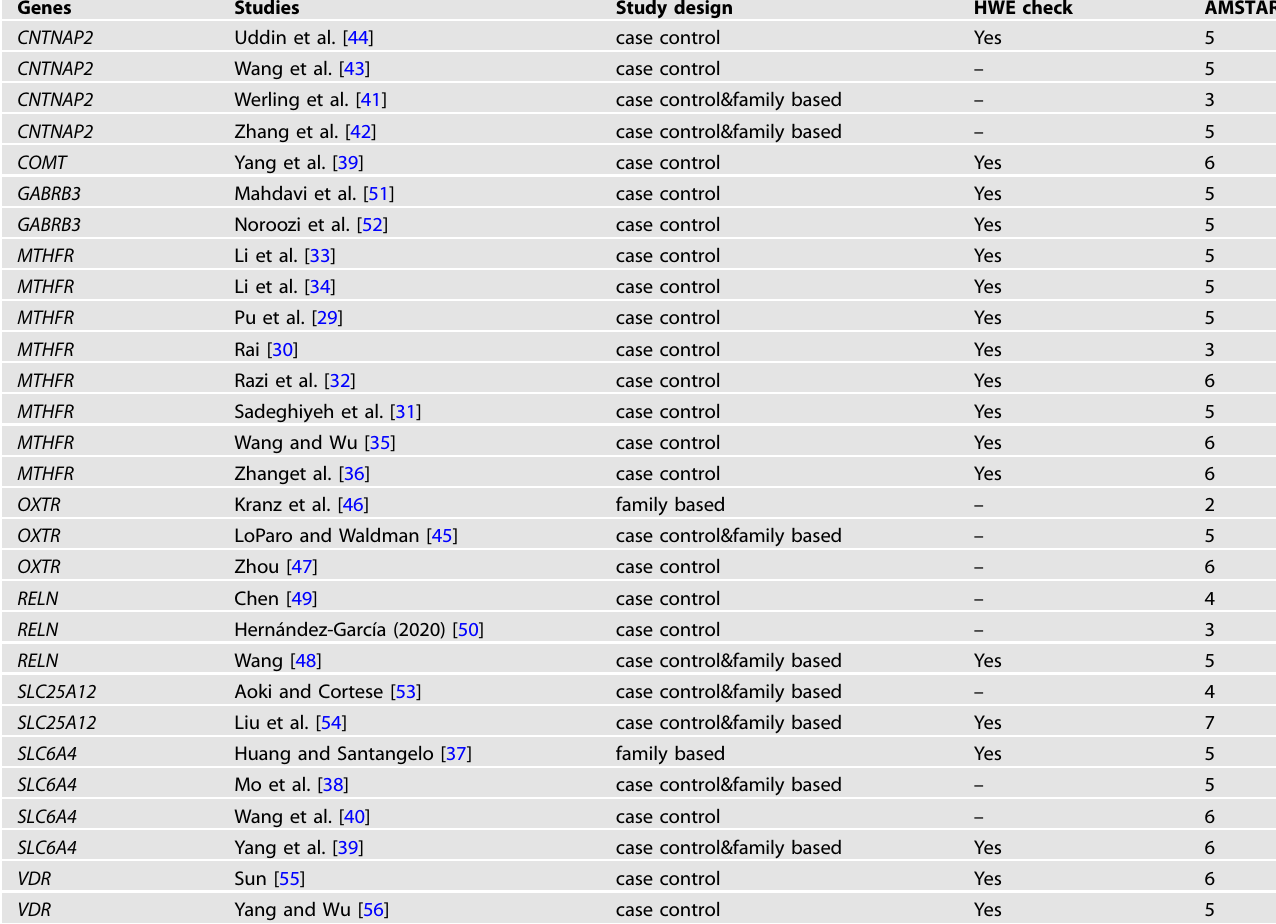
Table 1. Information on meta-analyses included in the umbrella